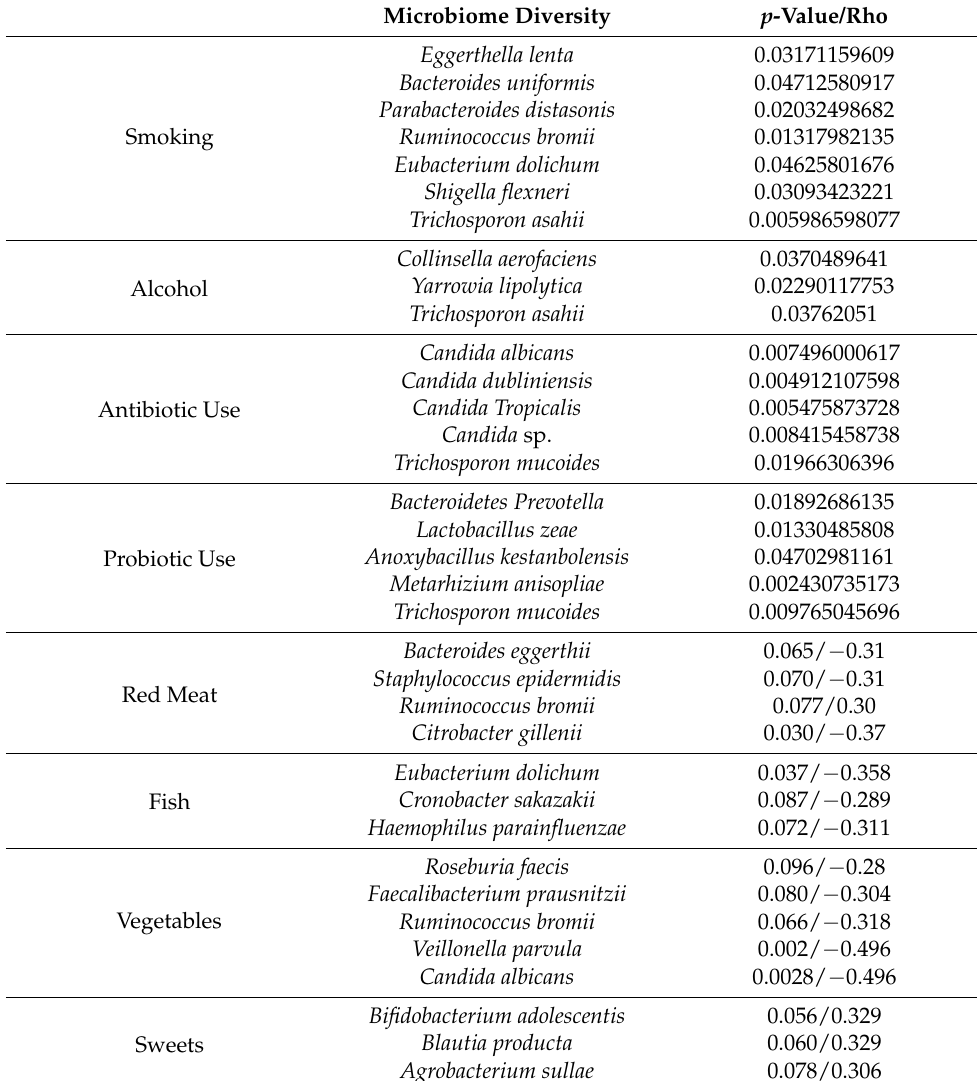
Table 2. Microbiome species associated with different dietary habits, antibiotic exposure and thera- peutic